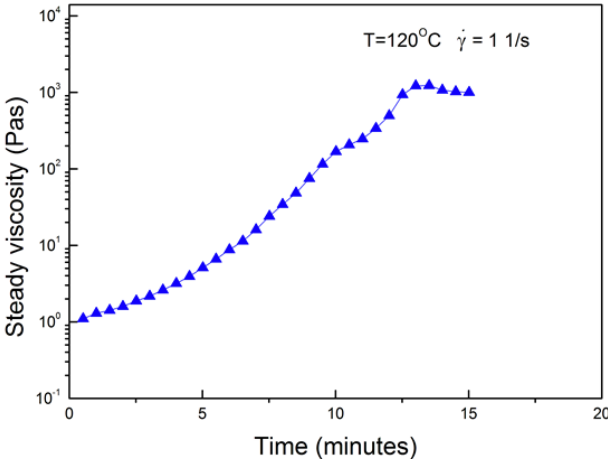
Figure 2. Isothermal shear viscosity for 3BOP-daC12 benzoxazine resin at a temperature of 120